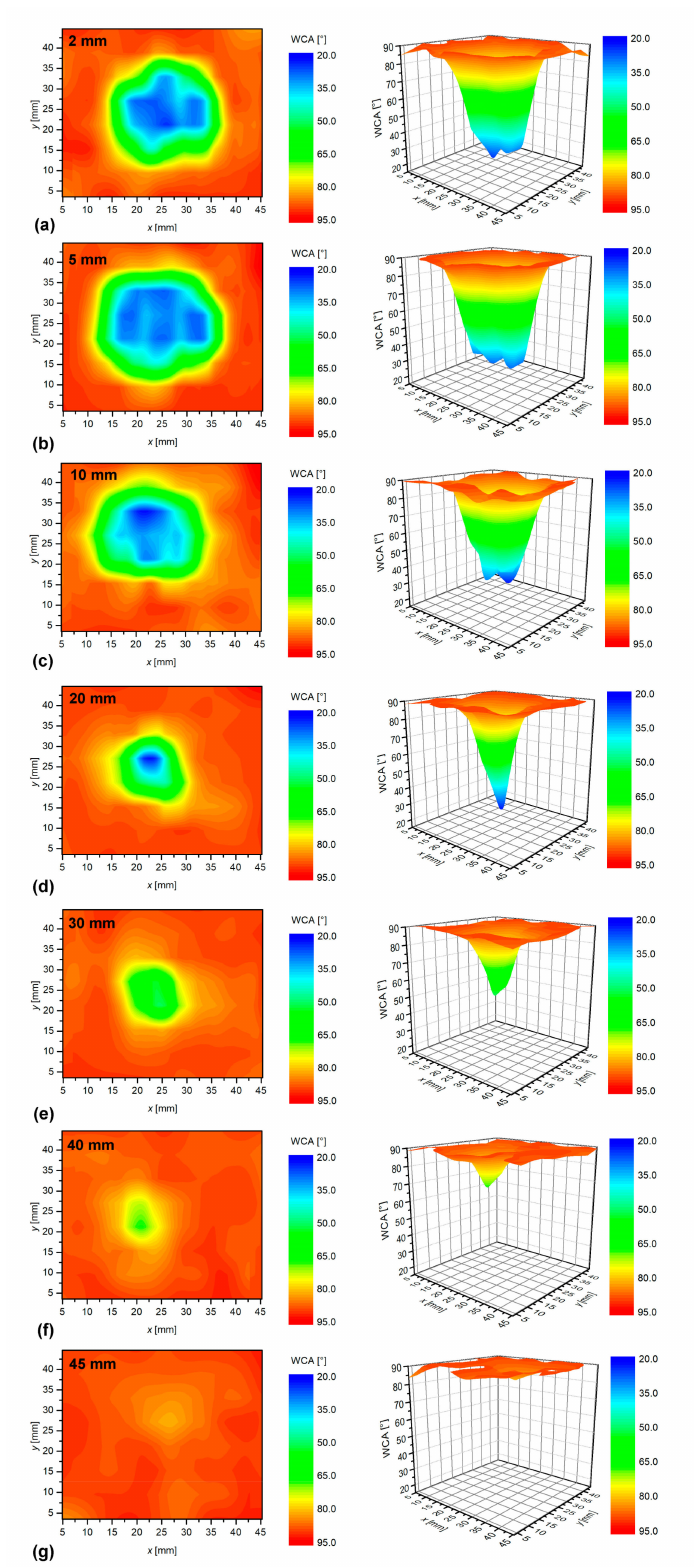
Figure 3. Evolution of the surface wettability for polystyrene treated at various distances from the atmospheric-pressure plasma jets (APPJ) nozzle: ( a ) 2 mm, ( b ) 5 mm, ( c ) 10 mm, ( d ) 20 mm, ( e ) 30 mm, ( f ) 40 mm, ( g ) 45 mm. The treatment time was 30